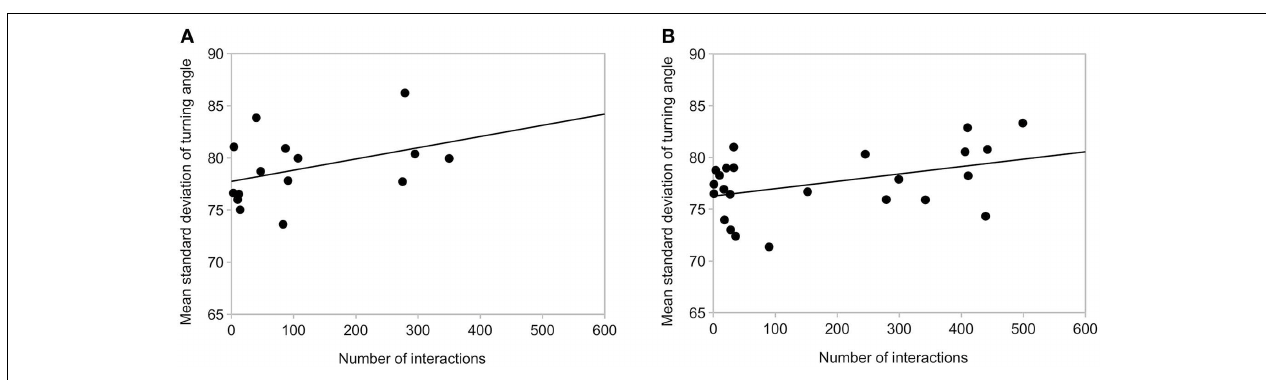
FIGURE 8 | Relation of mean standard deviation of turning angle and number of interactions. (A) Earth. (B) Space. Each point shows the mean standard deviation of turning angle and the number of interactions in one area: Area 1 closed, for 5min before the barrier